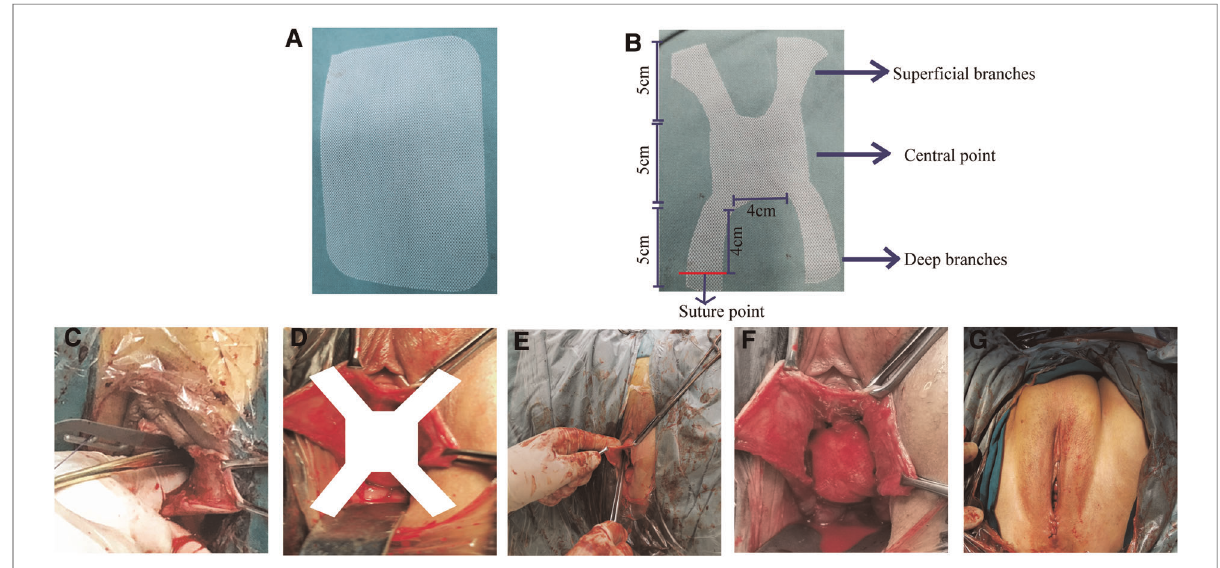
FIGURE 1 ( A ) The 10*15 cm original mesh. ( B ) Schematic diagram of the X-shaped mesh after construction. ( C ) Separation of the sacrospinous ligament. ( D ) Schematic diagram of X-mesh placemented in the body. ( E ) Fixed the mesh in the body. ( F ) Diagram of the complete placement of the mesh into the bod. ( G ) Postoperative of